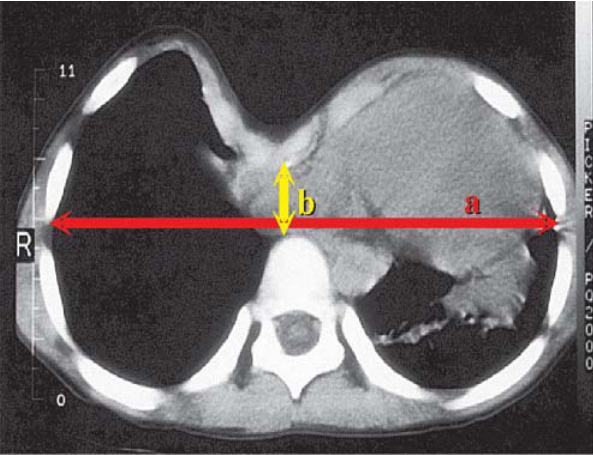
Figure 2 - Measurement of the pectus severity index using a CT scan. This is calculated by dividing the inner width of the chest at the widest point (a) by the distance between the posterior surface of the sternum and anterior surface of the spine (b)